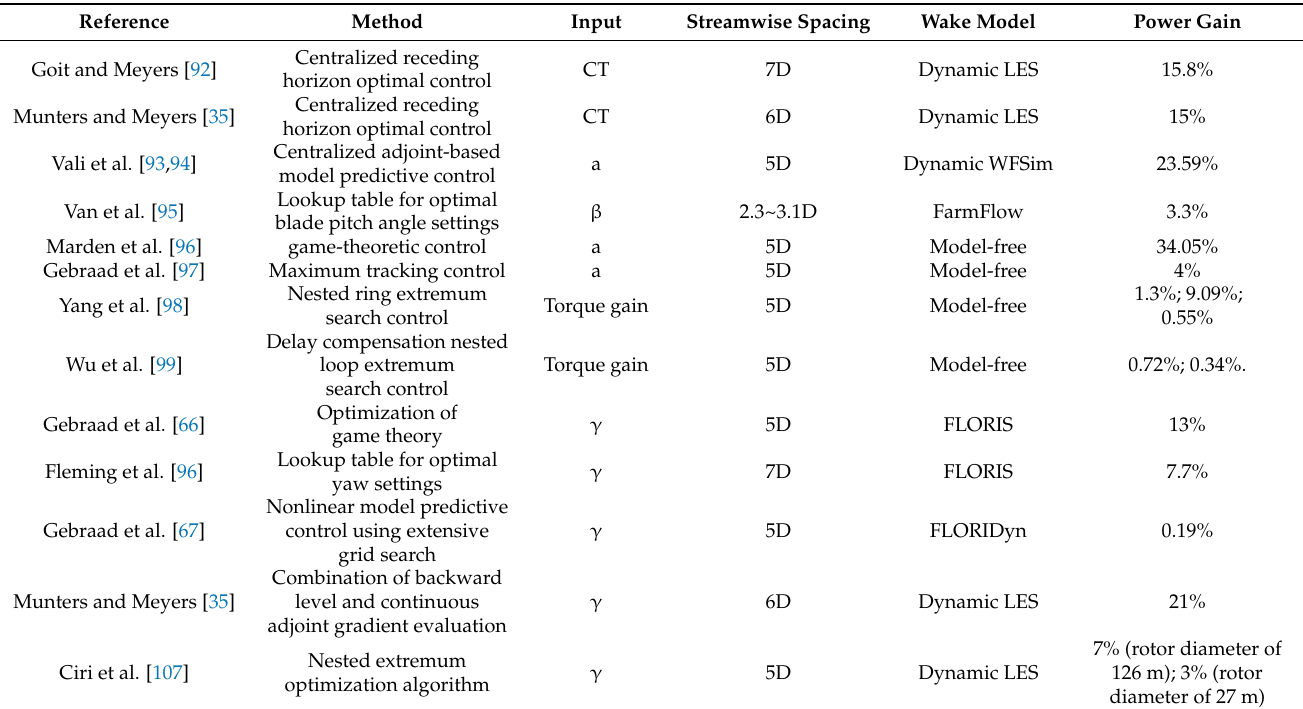
Table 2. Summary of reference wind farm dynamic control